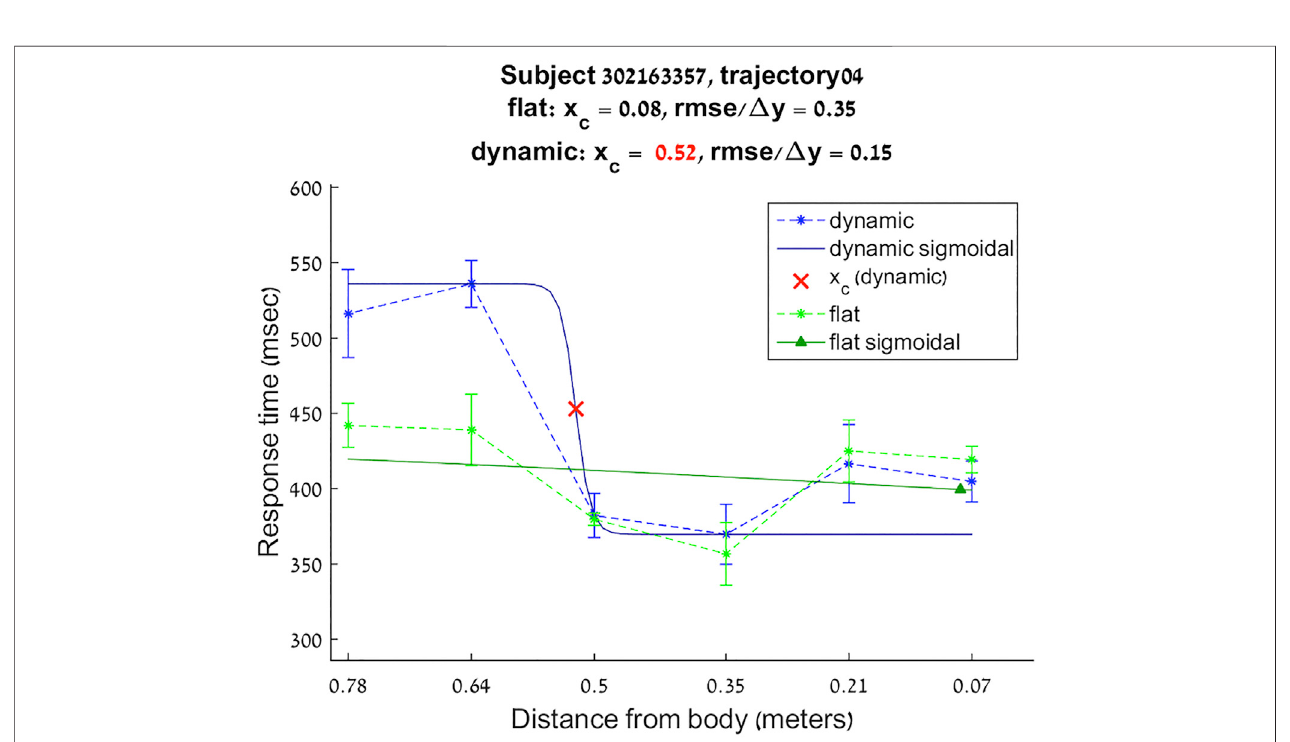
FIGURE 3 | Reaction times sigmoidal approximation for subject 302163357 trajectory 4 fl at and dynamic conditions.